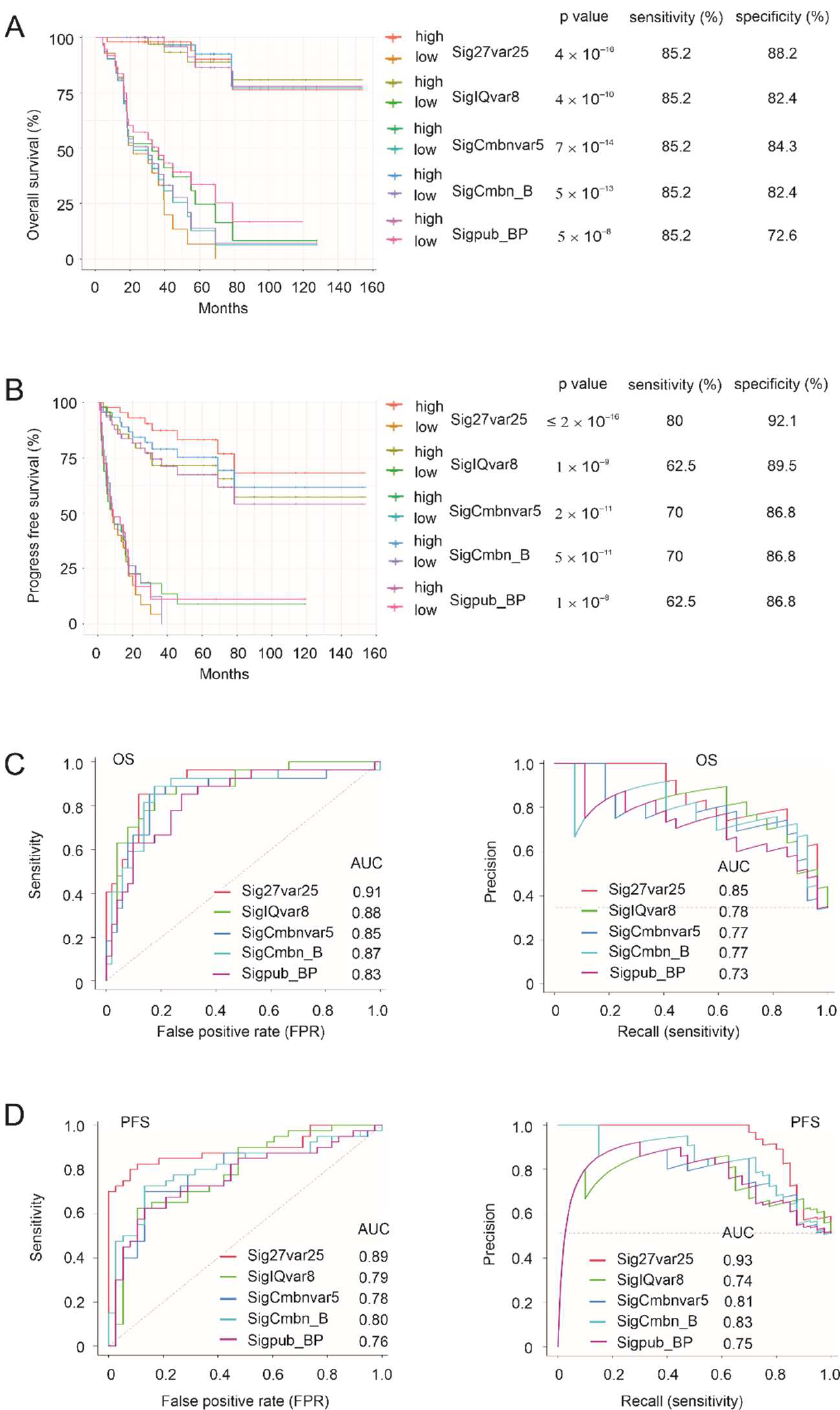
Figure 5. Comparison of progression and fatality risk stratification among Sig27var25, SigIQvar8, SigCmbnvar5, SigCmbn_B, and Sigpub_BP. ( A , B ) Cutoff points for the indicated signature scores were estimated by the empirical method. The individual survival curves, p -values, sensitivities, and specificities for OS and PFS are shown. ( C , D ) OS ROC and PR curves ( C ) and PFS ROC and PR curves ( D ) for the indicated signatures.